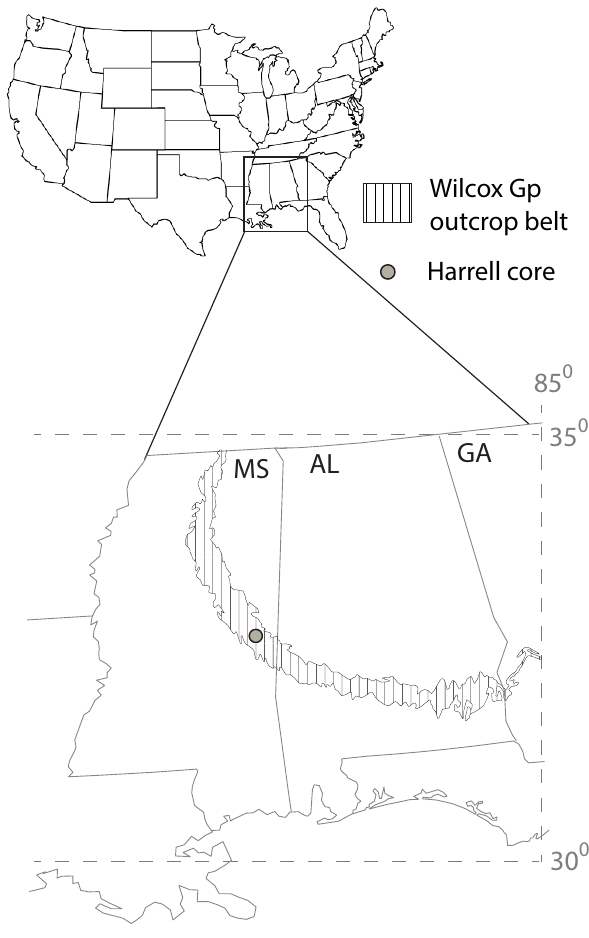
Figure 1. Location map of the Harrell Core in Meridian, Lauderdale Co., Mississippi, USA, and outcrop belt of the Wilcox Group, com- prising the Paleocene and early Eocene Nanafalia, Tuscahoma and Hatchetigbee formations along the eastern Gulf of Mexico. Map was modified from Schruben et al.